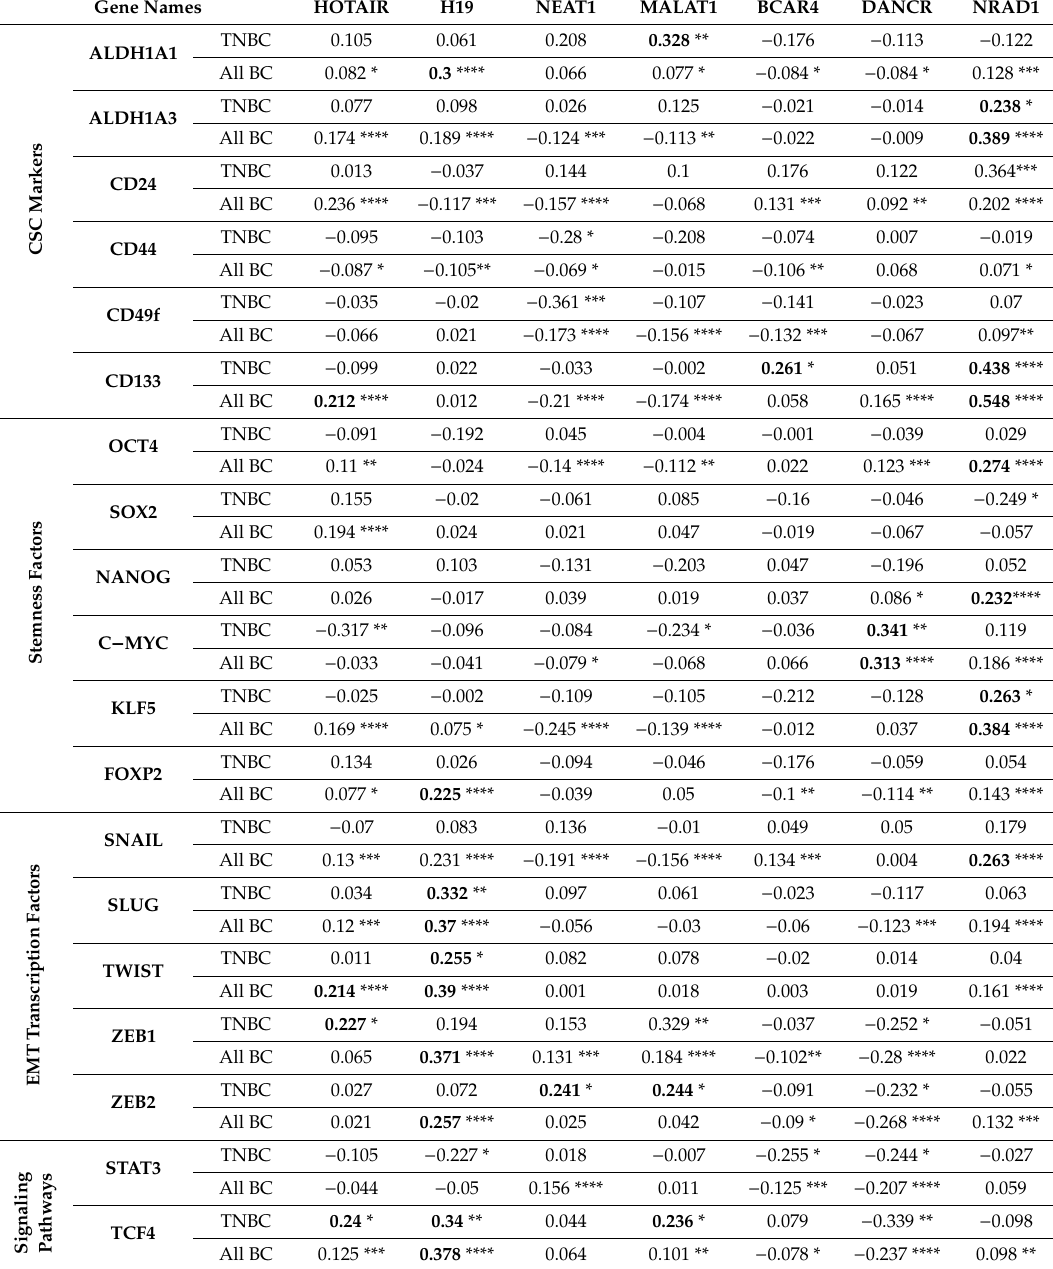
Table 2. LncRNA co-expression with CSC markers, stemness factors, EMT genes, and players in CSC-associated signaling